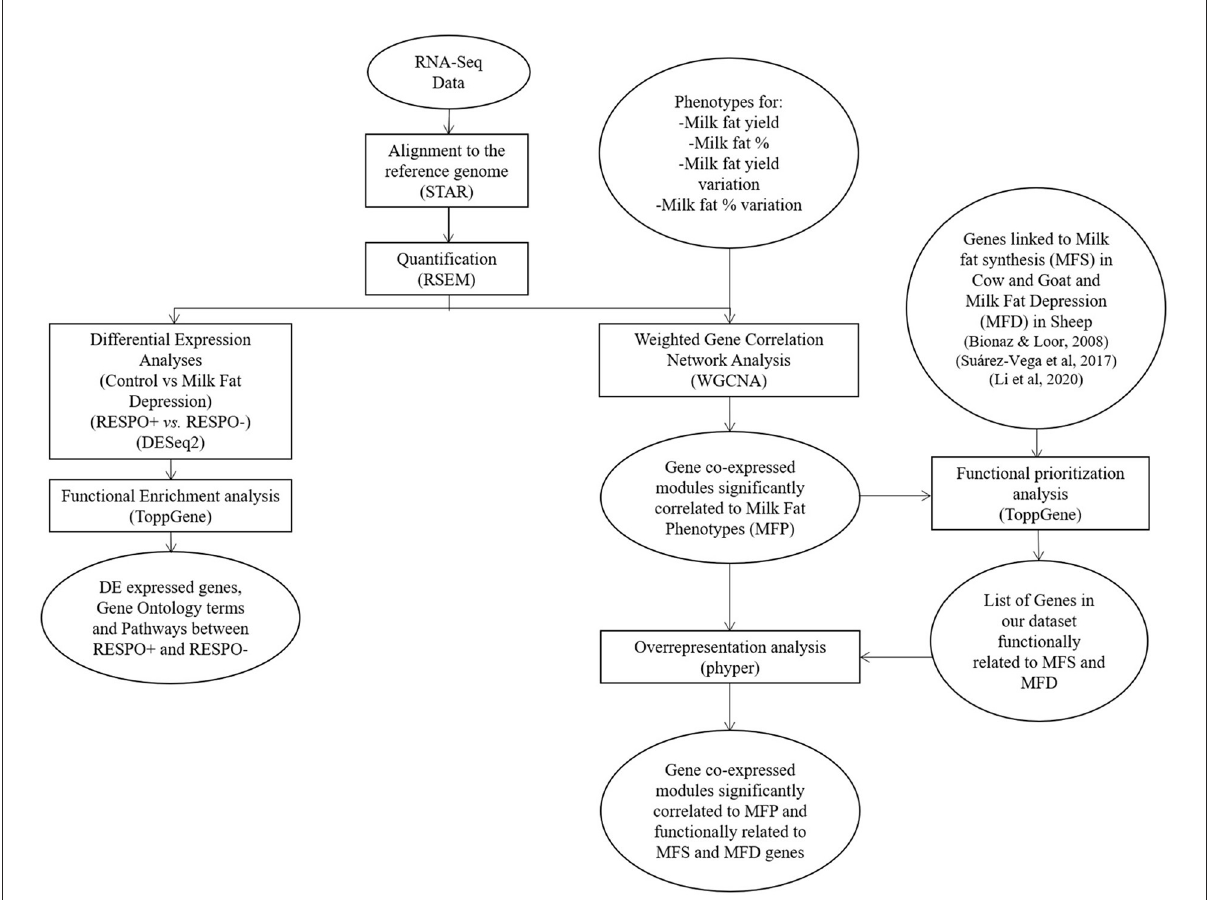
FIGURE1 Bioinformatics workflow followed for the analysis of the RNA-Seq